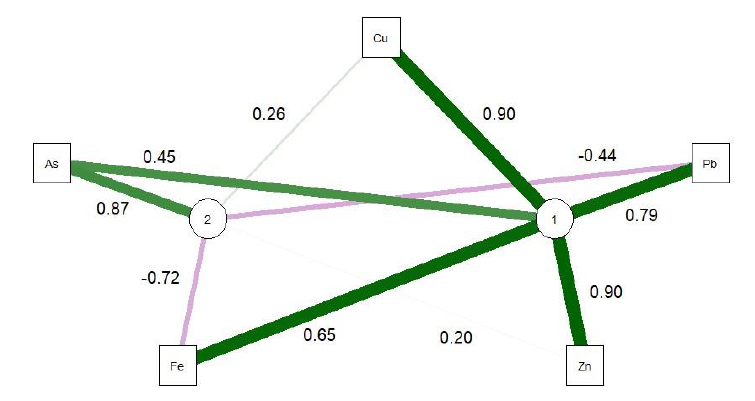
Figure 4. Correlation of heavy metal and arsenic vectors with major components.